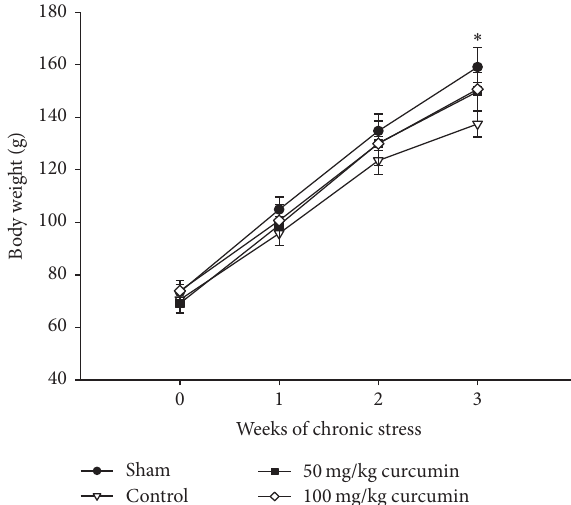
Figure 6: Effects of curcumin administration on behavior immo- bility in forced swim test. Curcumin was administered for 18 days before the FST. The immobility time was measured during a 6min experimental session. Data are shown as mean ± SEM. According to Kurtosis figure or Kurtosis/Kurtosis error, each group had normal distribution. ∗ 𝑝 < 0.05 versus control by ANOVA. In addition, ∗ 𝑝 < 0.05 by Kruskal-Wallis